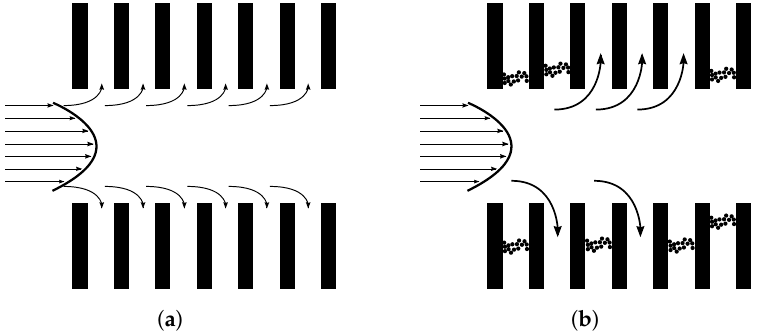
Figure 4. Fouling under sub-critical flux operation. ( a ) Pre-blockage; ( b ) Post-blockage.